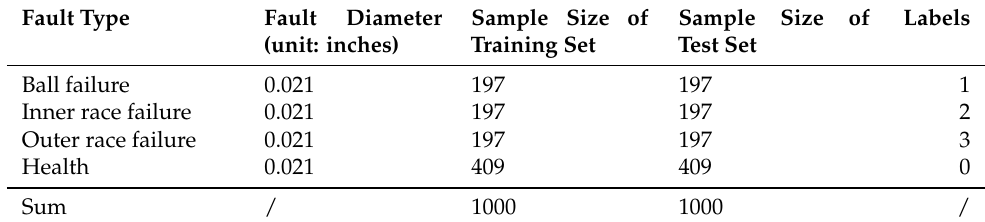
Table 4. Sample size and labels for training set and test set.